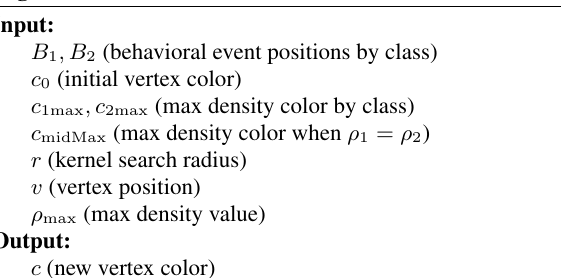
Algorithm 2 Bivariate Vertex Color